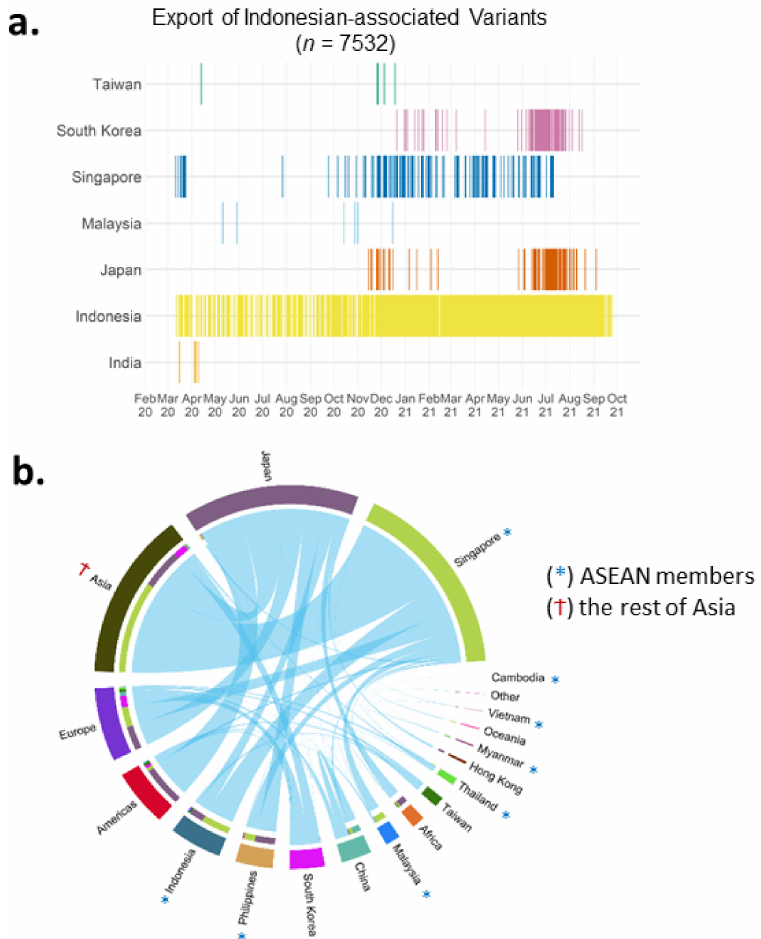
Figure 6. Inter-nation transmission of variants. ( a ) Timeline of the Indonesian-associated variants based on export to other countries, showing Singapore as the most frequent destination. ( b ) World- wide transmission showing the highest events from/to Singapore and